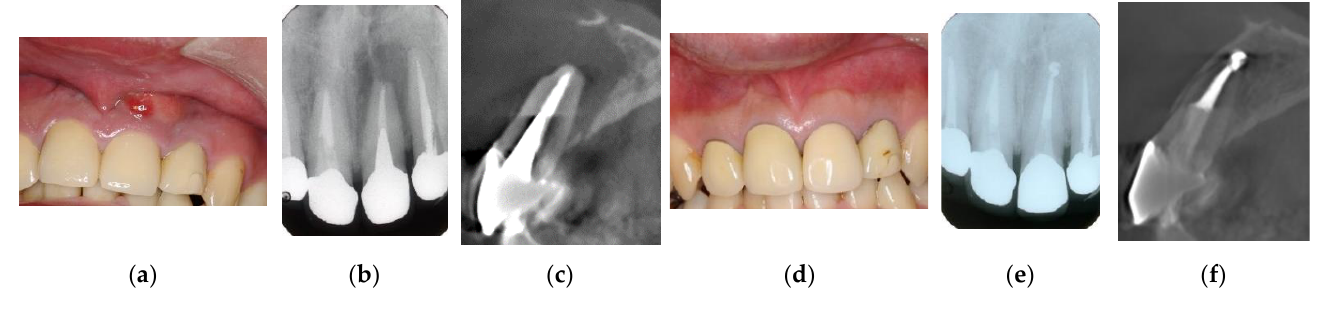
Figure 5. Clinical case 4. Male, age 34 yrs. ( a ) Intraoral view of the upper left incisor at baseline. ( b ) Preoperative periapical radiographs of the upper left incisor, with the “bone” defect presenting as a radiolucent area in the apical lesion. ( c ) Preoperative CBCT showing a radiolucent lesion on the labial, periapical, and palatal areas. ( d ) Intraoral view 2 years after treatment. ( e ) Follow-up periapical radiograph 2 years after treatment. ( f ) Follow-up CBCT 2 years after treatment, showing root canal filling and healing. (GTR) [16,50].